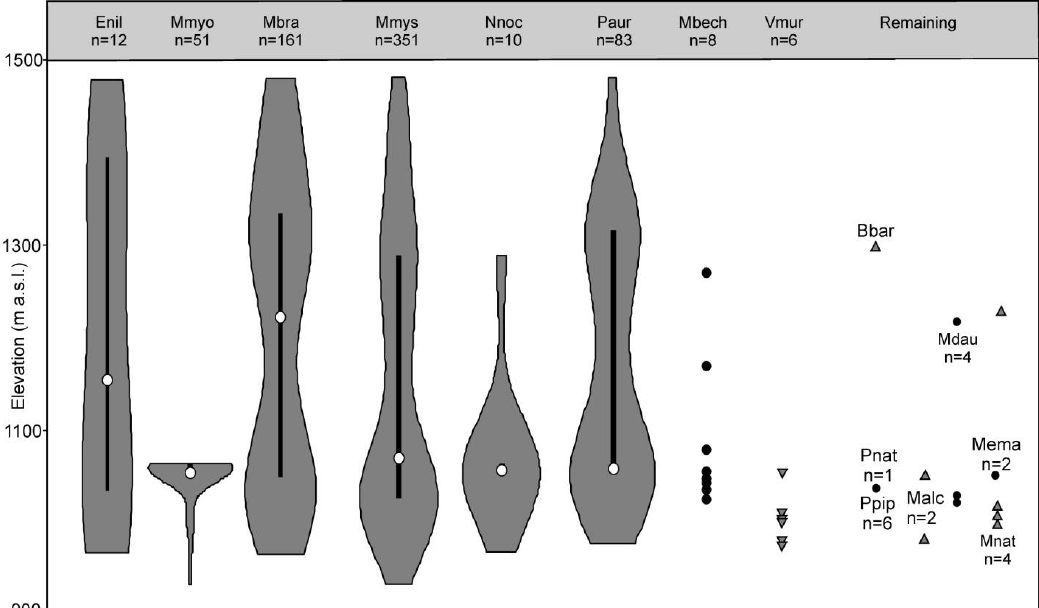
Figure 2. Distribution pattern of bats in forests of the Polish Tatra Mountains, 2016 – 2020 along the elevation gradient expressed with kernel density estimators and boxplots. Violin plots were used when the bat number was ≥10. Total abundance of each species is given below its abbreviated name: